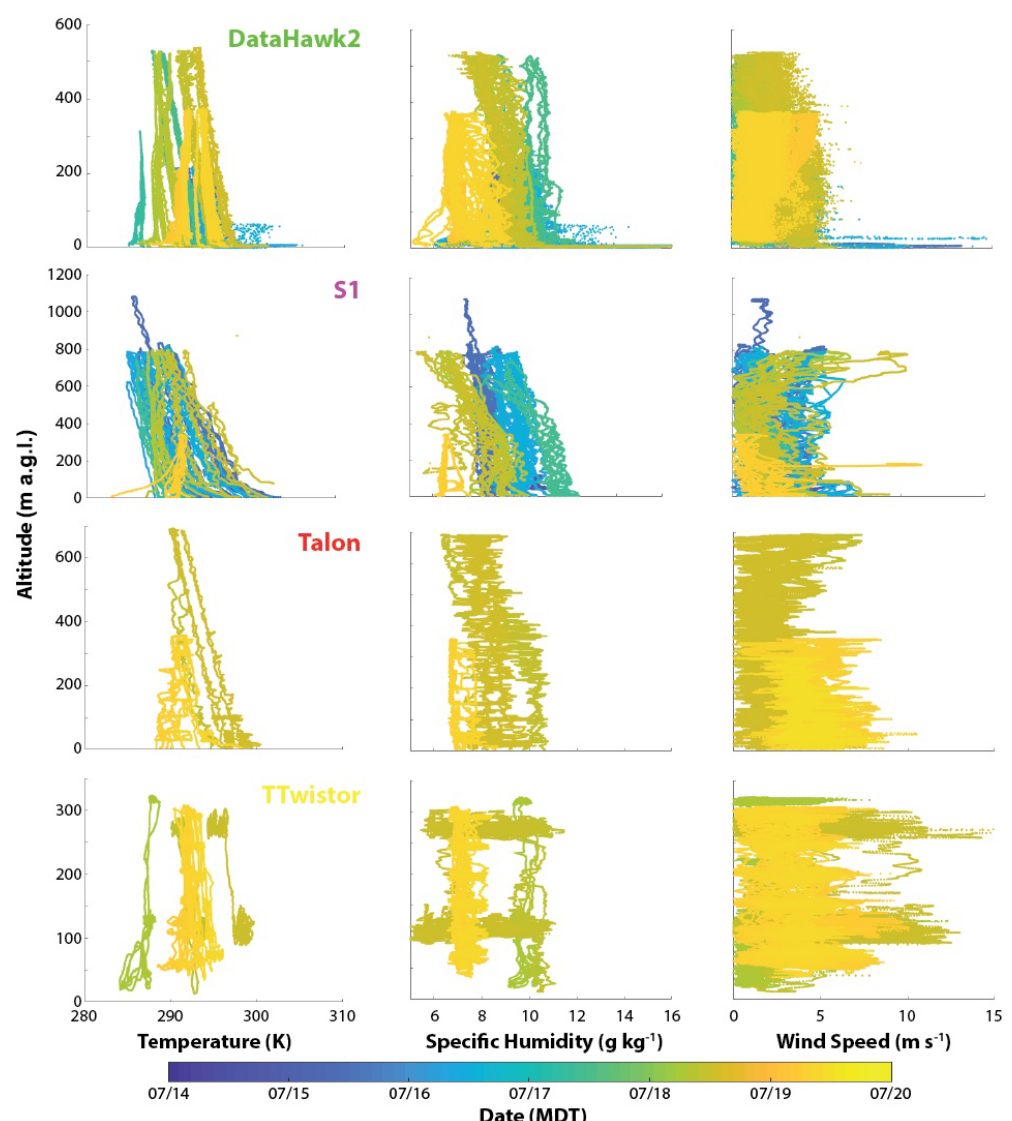
Figure 7. Profiles of (left to right) temperature, specific humidity, and wind speed from the DataHawk2, S1, Talon, and TTwistor (top to bottom). Colors indicate the date of flight. Please note that the altitudes are shown as above ground level (a.g.l.), and some aircraft were operating at different locations each day and from one another, meaning that the ground levels in this figure represent different elevations relative to sea